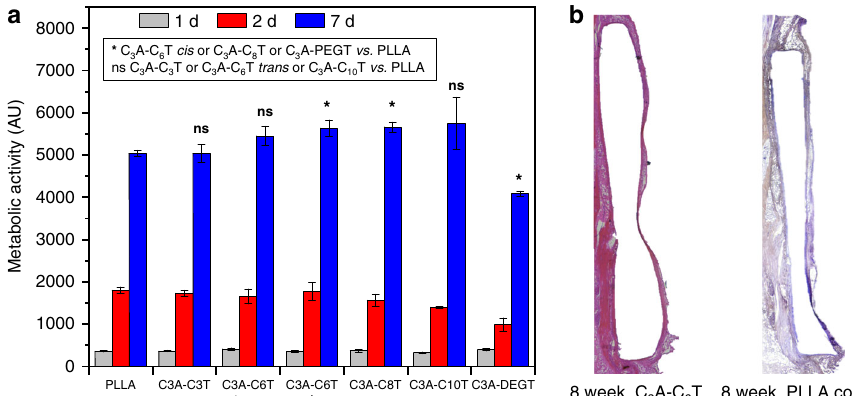
Fig. 4 Cell biology and in vivo study. a Cytocompatibility assays for all polyamides. Statistical analysis was performed using an ordinary two-way ANOVA test between the 7-day cell proliferation data on PLLA and each of the polymers synthesised ( P < 0.05). Error bars represent 1 s.d. b Histological analysis of C 3 A-C 6 T and PLLA implanted samples. PLLA was used as the